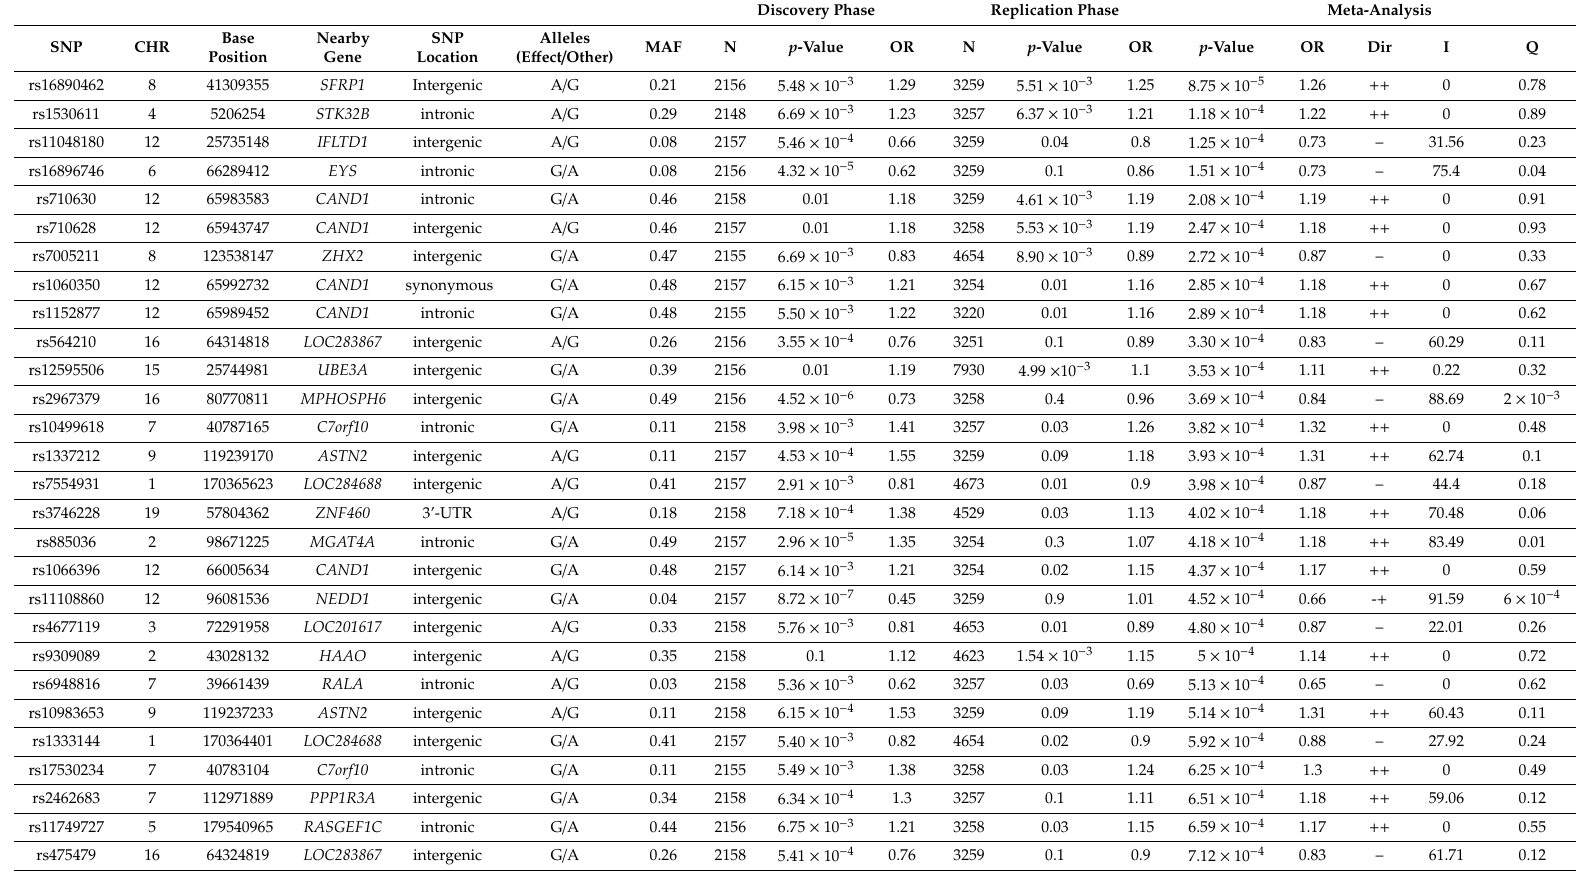
Table 2. Novel signals associated with MetS ( p -value < 1 × 10 − 3 ) in meta-analysis in